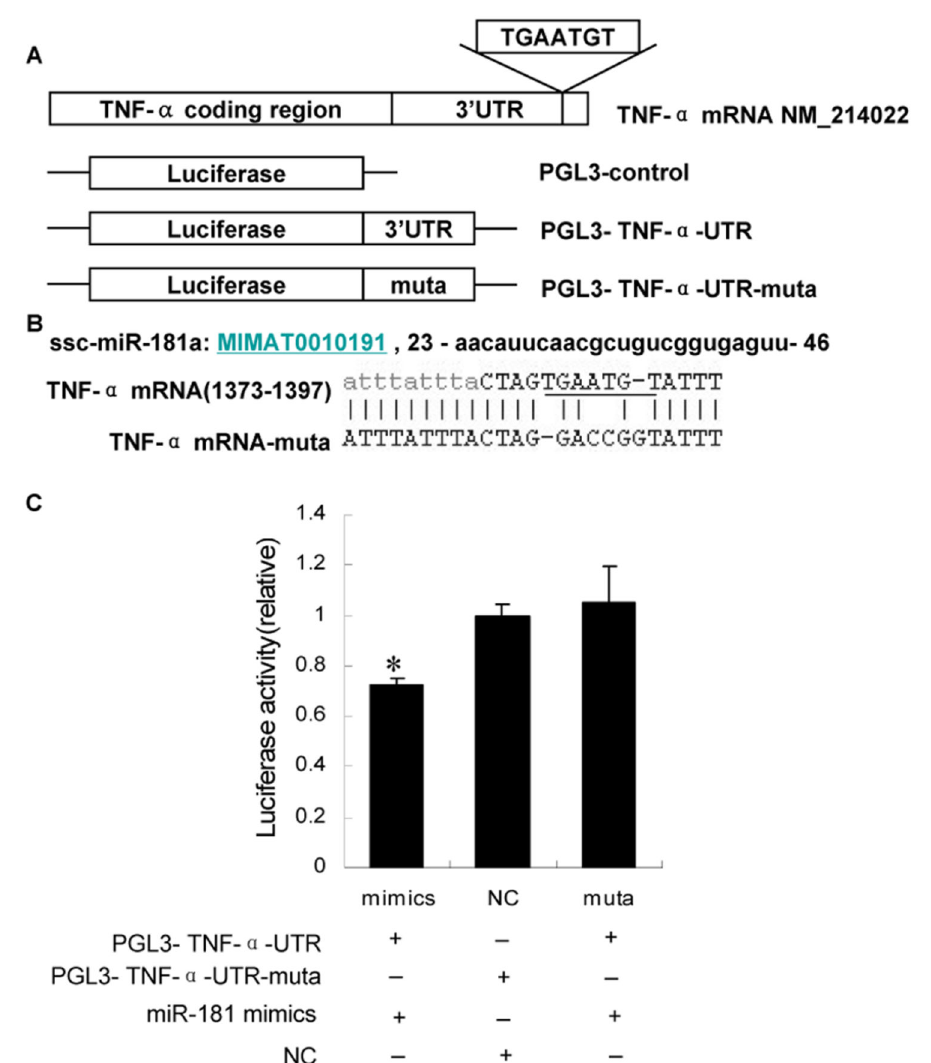
Figure 1. MiR-181a directly regulates TNF-α expression via 3’ UTR sites. (A) Schematic of TNF-α mRNA and the luciferase reporter plasmids containing the miR-181a binding sites of TNF-α mRNA. The 3’ UTR sites were inserted downstream of the luciferase reporter, as indicated. TGAATGT was the predicted target site of miR-181a . (B) MiR-181a sequences and predicted binding site between miR-181a and TNF-α mRNA. Sequence of miR-181a (www.mirbase.org) is shown. TNF-α mRNA has one putative binding site for miR-181a on the 3’ UTR. Seven nucleotides of TNF-α 3’ UTR (underlined) were replaced with GACCGGT using site-directed mutagenesis in order to disrupt the binding with miR-181a seed regions. (C) CHO cells were transfected with each of the constructed plasmids, together with miR-181a and Renilla luciferase reporter plasmid (* P < 0.05, n = 8).